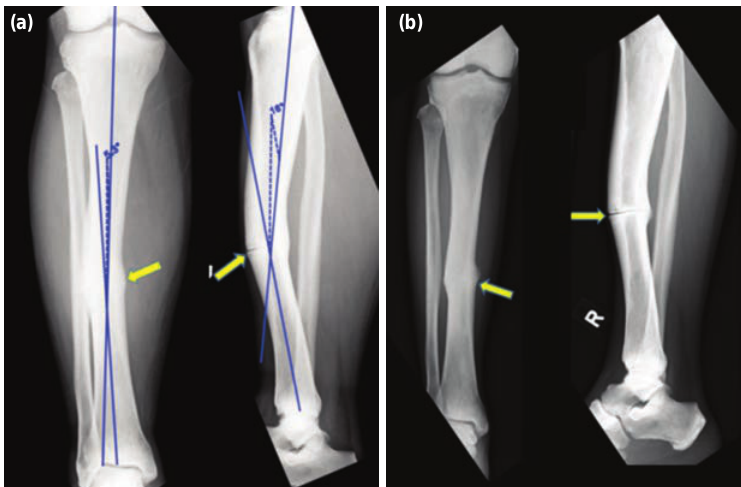
Pre-operative radiographs. (a) AP and lateral radiographs showing a fracture of the midshaft of the right tibia. The yellow Fig. 1: arrow indicates the fracture site. The blue lines depict the angular deformities. On the AP radiograph, a varus angulation of 5.3° is seen. On the lateral radiograph, a procurvatum deformity of 16° is seen. (b) AP and lateral radiographs after nine months of follow-up showing non-union of the midshaft of tibia.